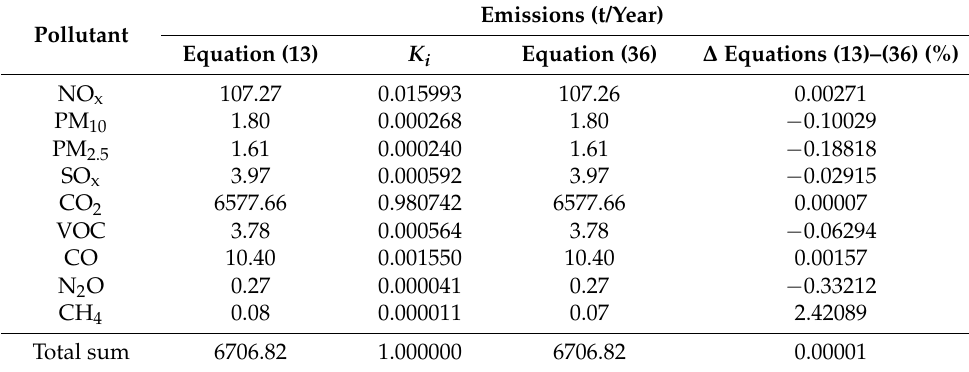
Table 21. Emissions estimation results comparison by pollutant.